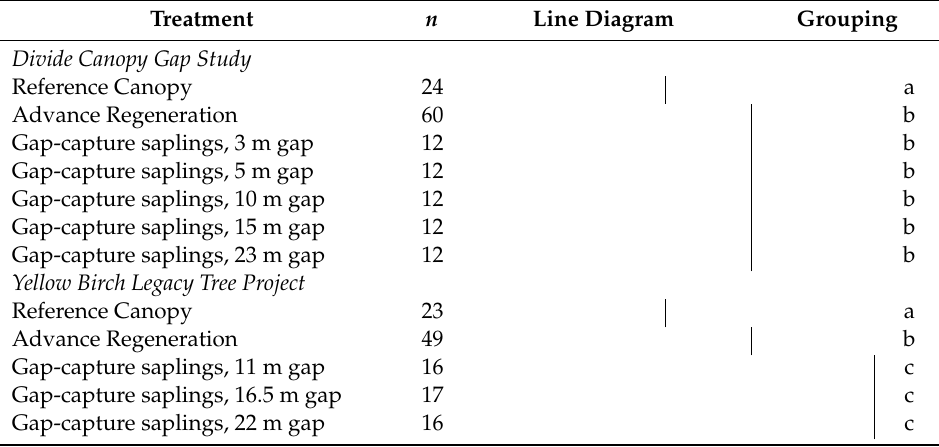
Table 2. Species compositional di ff erences of gap-capturing saplings (DCGS: 23 years post-harvest, YBLP: 15 years post-harvest) in group selection openings, reference canopies (year preceding harvests), and advance regeneration (2 years post-harvest) at two group-selection study sites in northern hardwood forests of the upper Great Lakes, USA. Groupings calculated with multiple response permutation procedures, and α = 0.05 was corrected for multiple comparisons with a false-discovery rate of